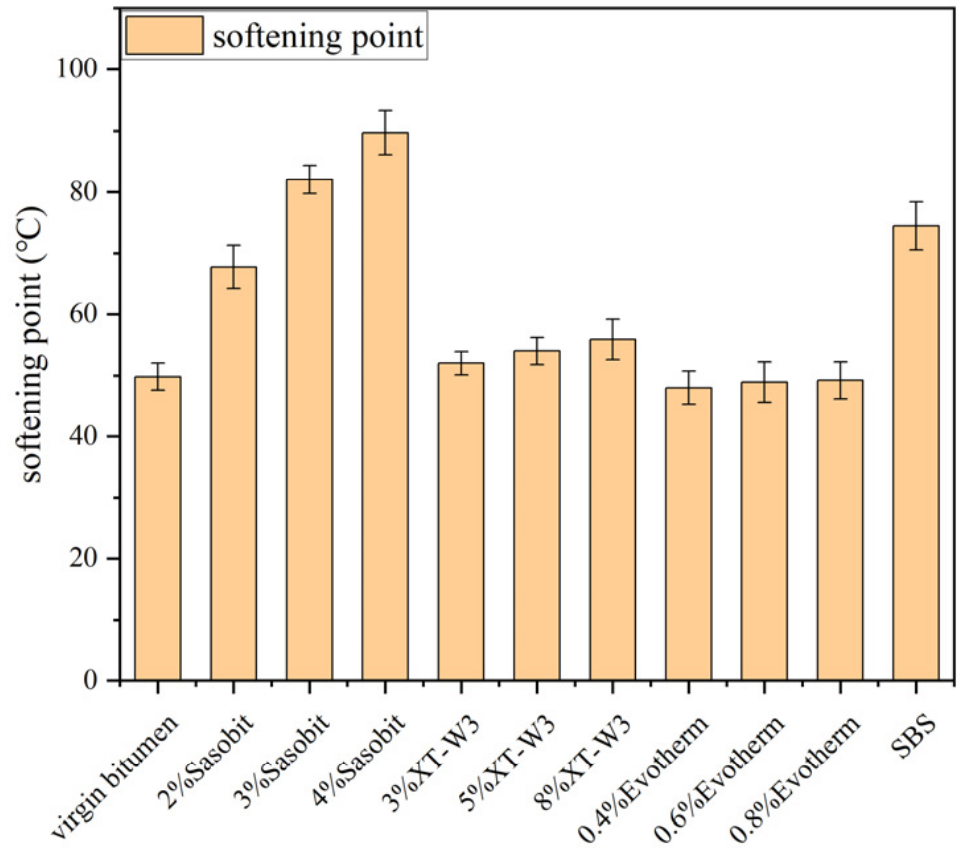
Figure 2. Softening point test results.